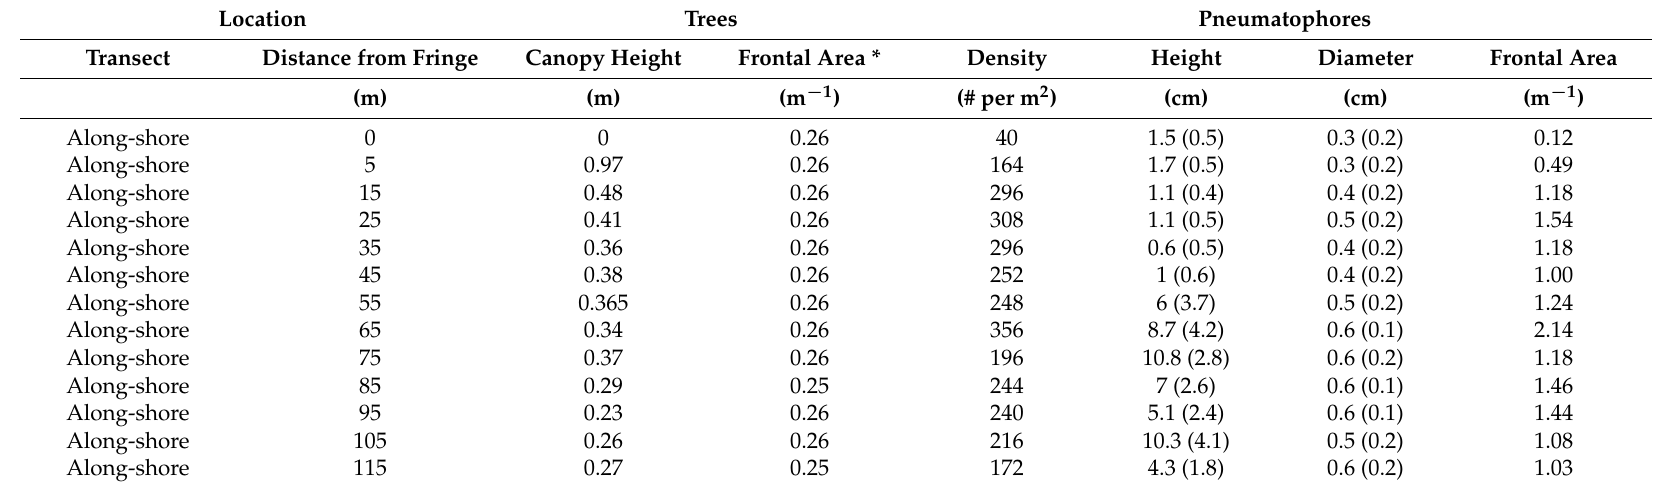
Table 4. The Tauranga vegetation survey summary. The values given are averages with the standard deviation where